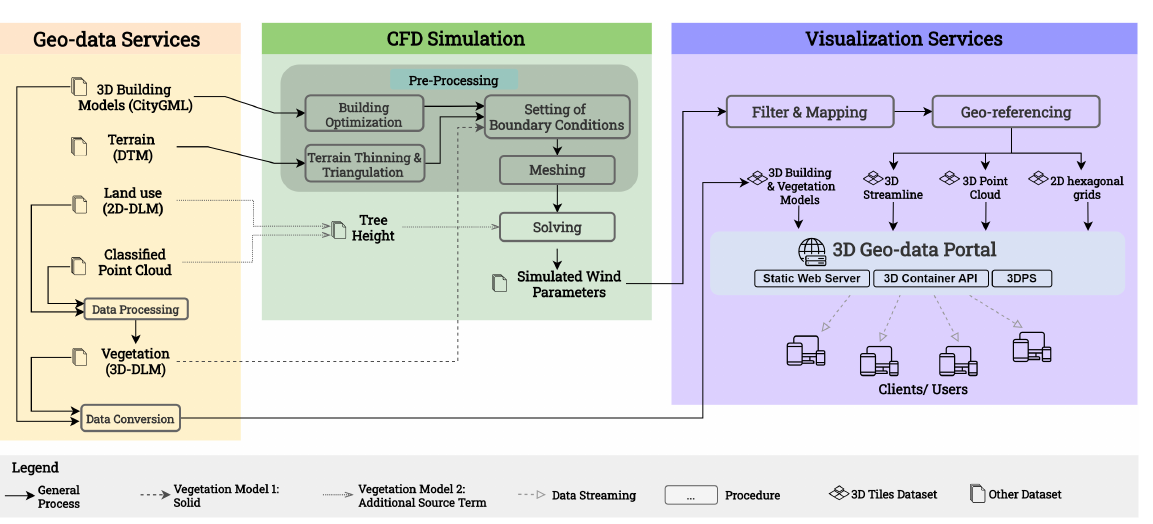
Figure 1. Workflow Overview: From CityGML and 3D-DLM to Visualization of urban wind fields in a 3D Geo-data